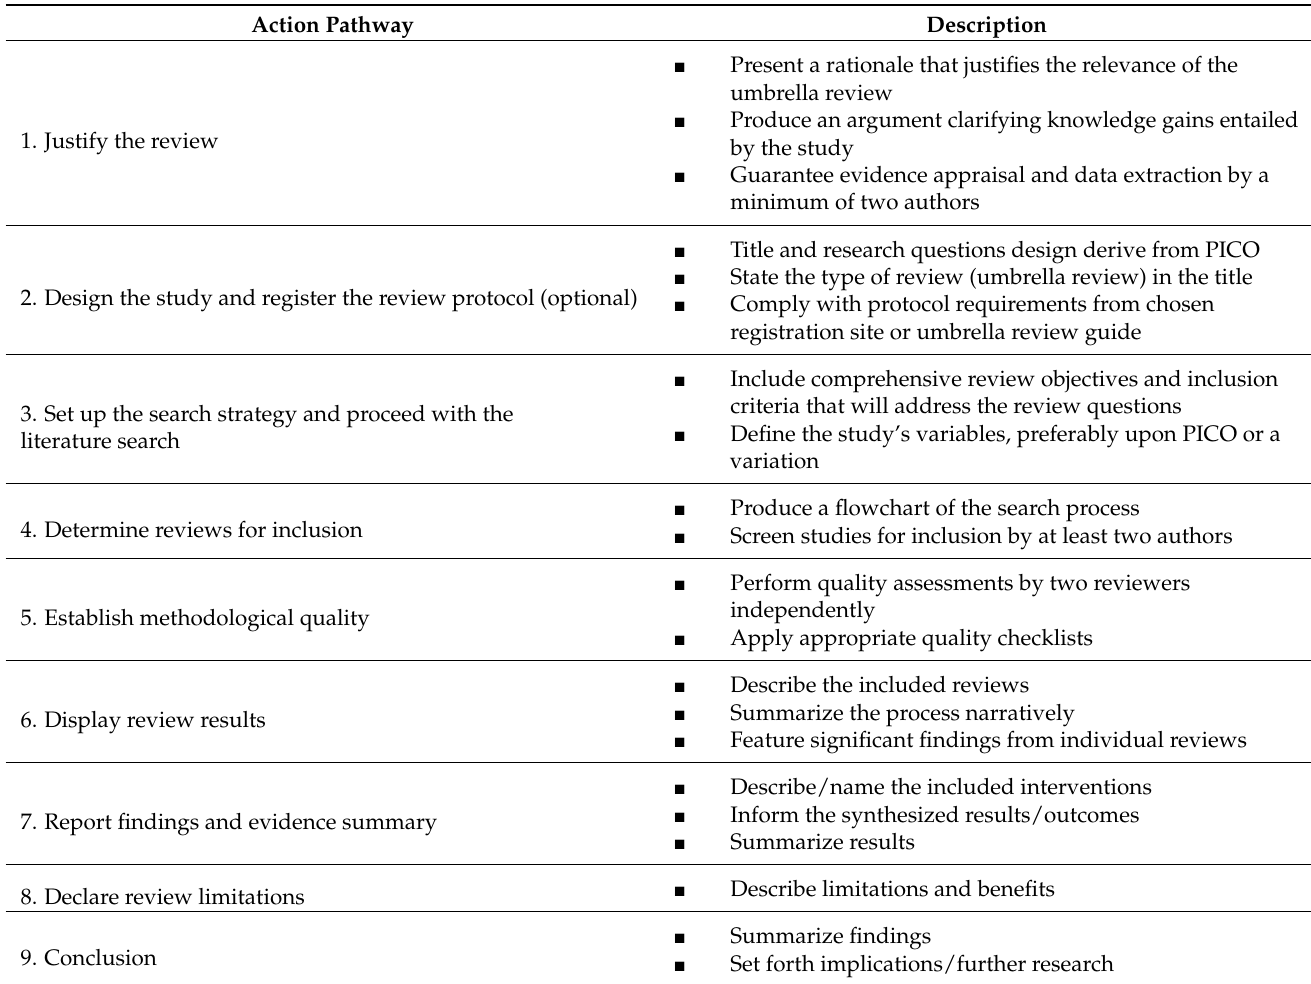
Table 1. Nine-step pathway for conduct of an umbrella review